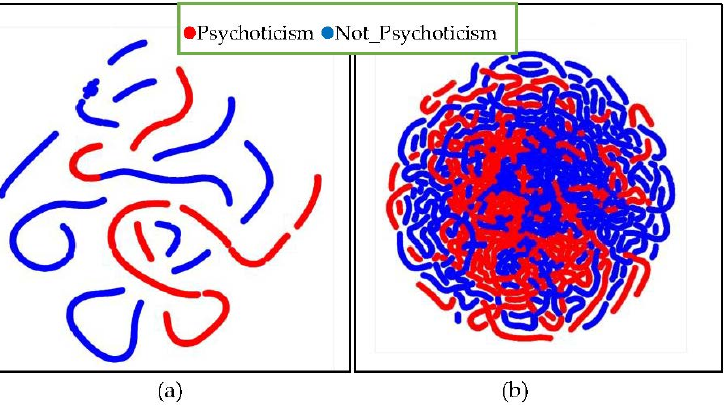
Figure 6. t-SNE visualization for one vs. all distribution of myPersonality ( a ) and Sentiment140 ( b ).